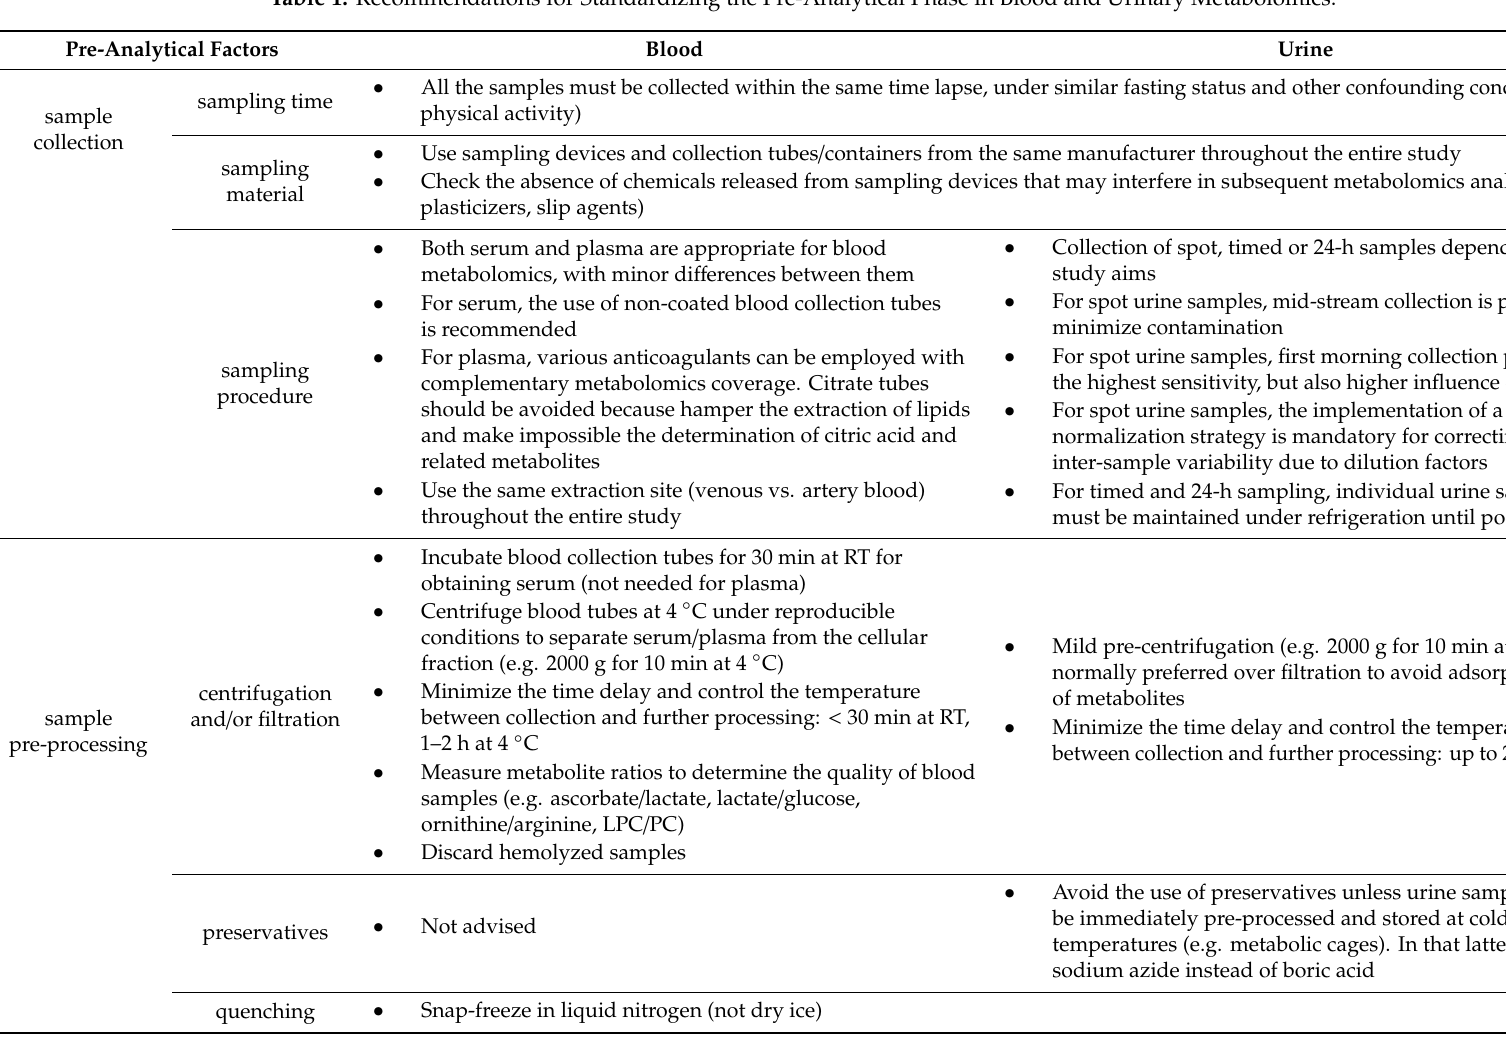
Table 1. Recommendations for Standardizing the Pre-Analytical Phase in Blood and Urinary